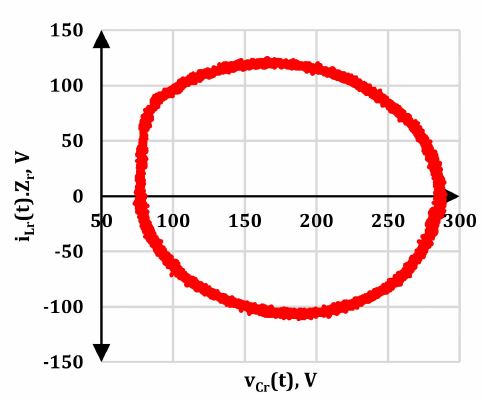
Figure 16. Measured state–space trajectory curve in the pure - SRC conditions.